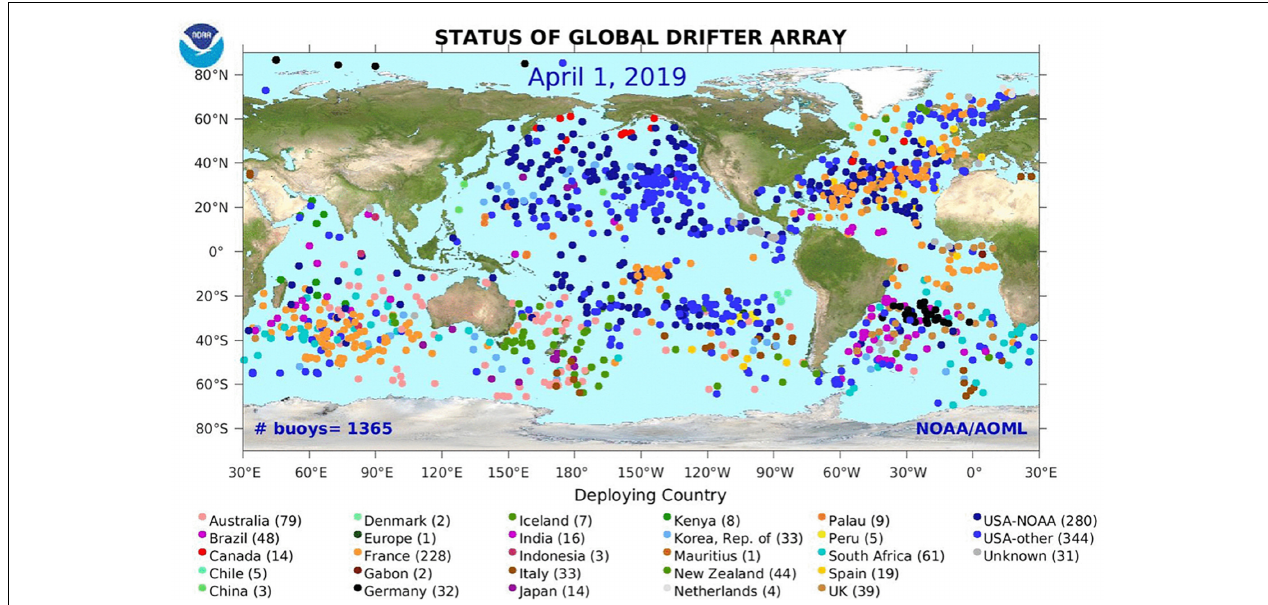
FIGURE 1 | Location of SVP drifters forming the GSDA array, color coded by deploying